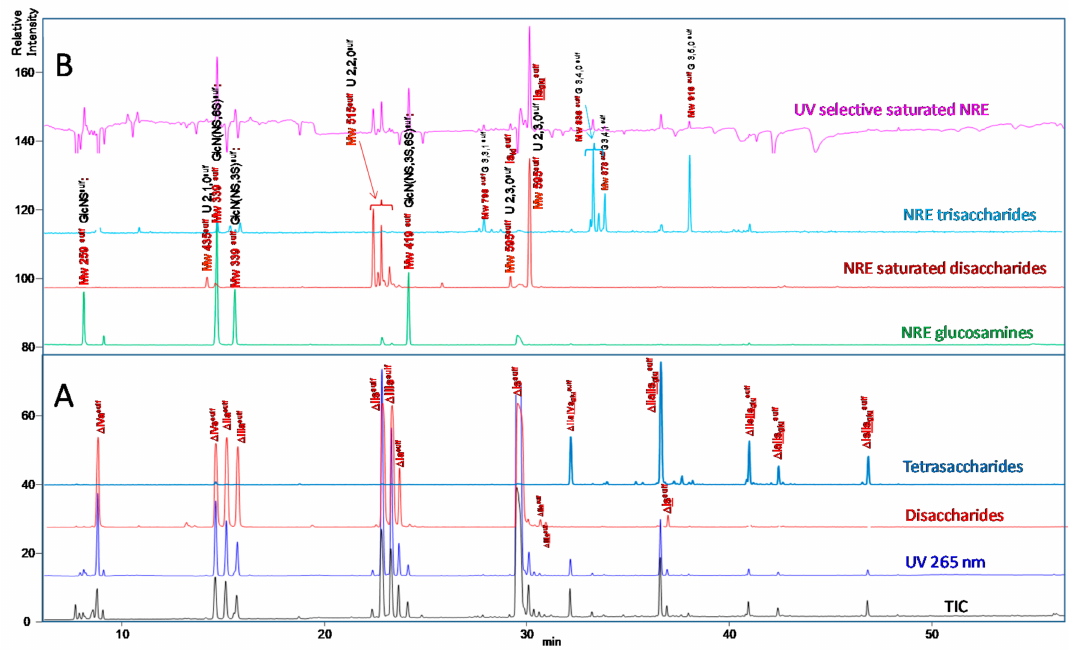
Figure 4. Chromatogram on ion-pair LC / MS of a digest of PMH with sulfanilic